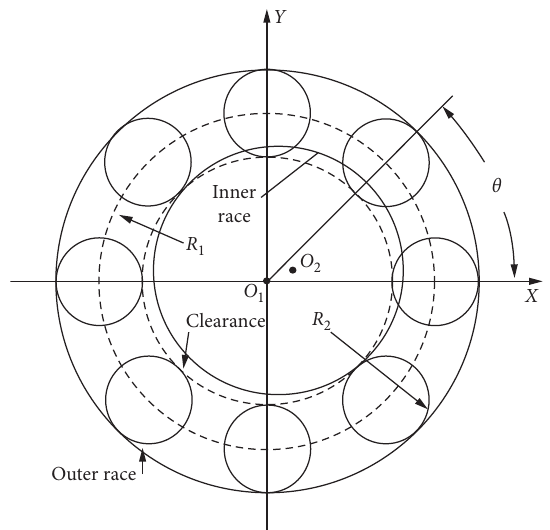
Figure 1: The schematic diagram of the rolling element